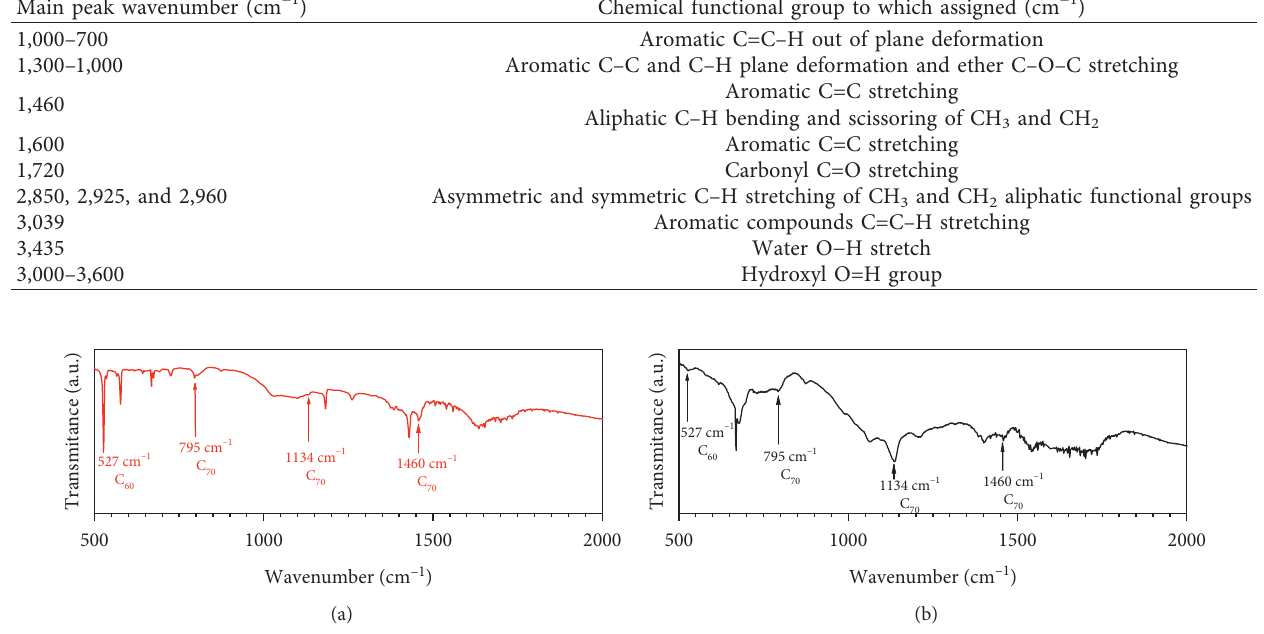
Figure 4: (a) Spectrum of the soot deposits formed after irradiating a 10 hPa of VBr pure sample with the CO Spectrum of a synthetic fullerene sample.